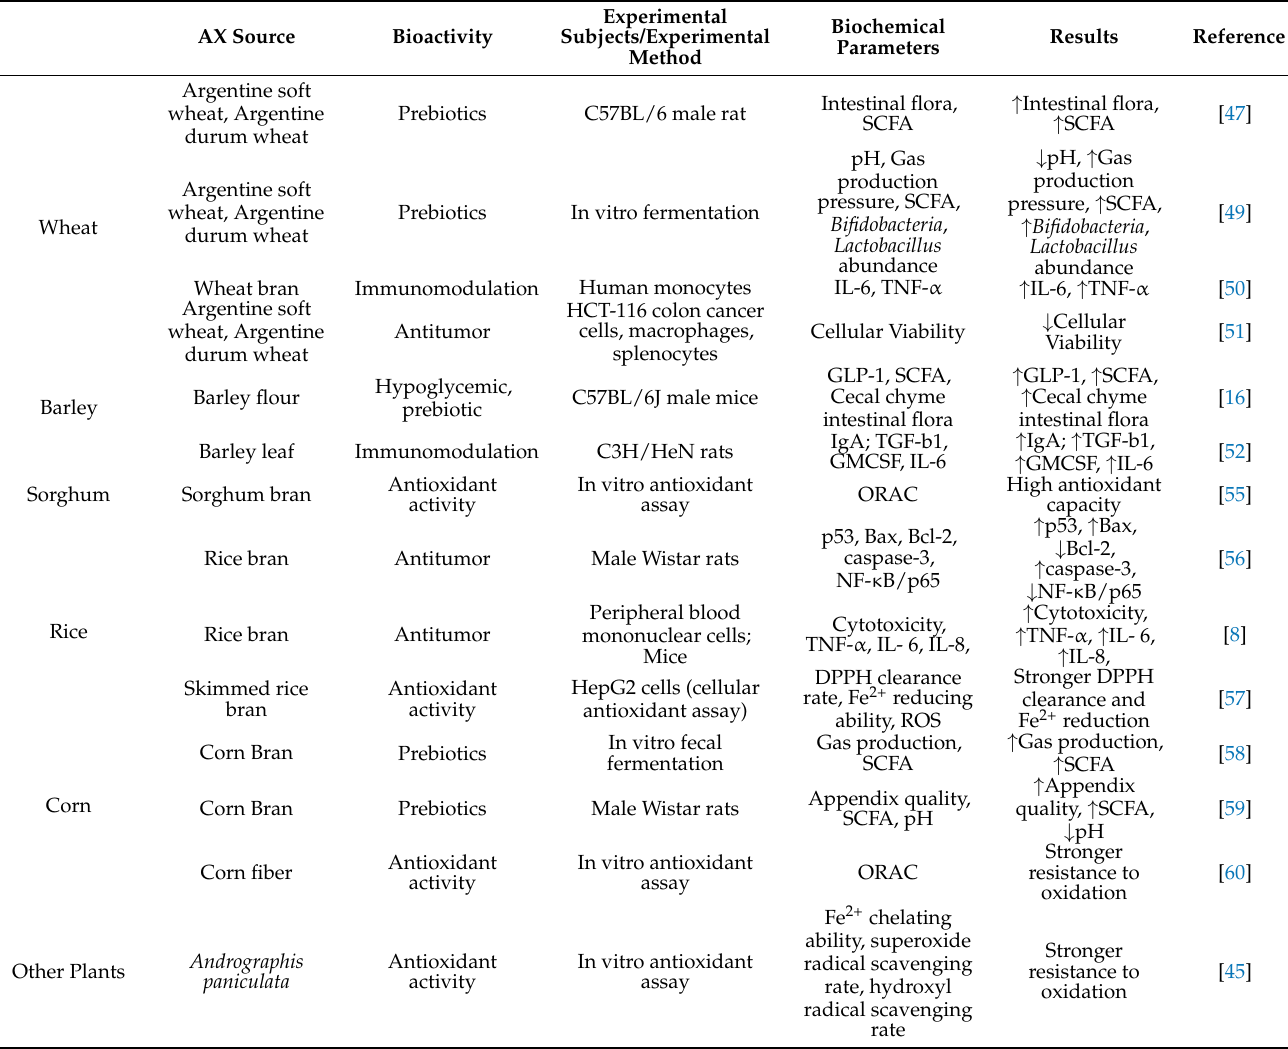
Table 2. Biological Activity of AX from Different